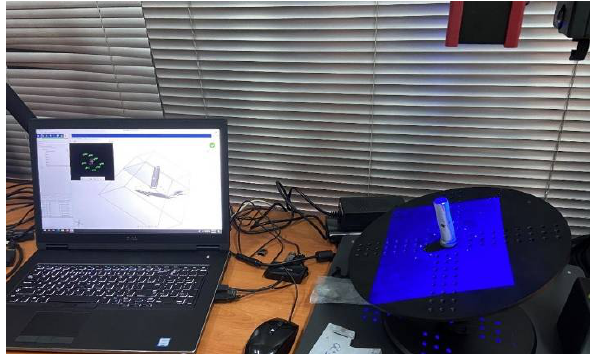
Figure 9. Optical 3D-scanning procedure of the impacted battery.